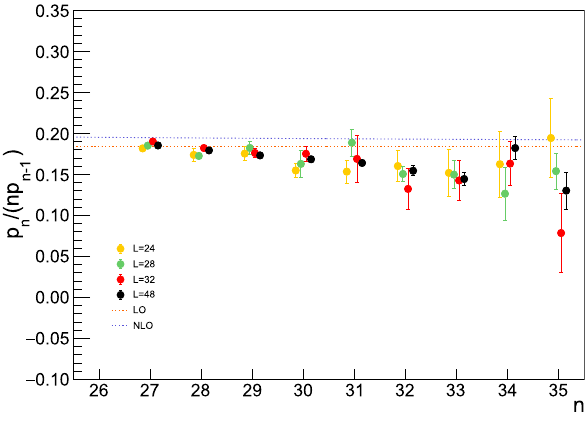
Fig. 10 Same as Fig. 9, but the region at large n is enlarged